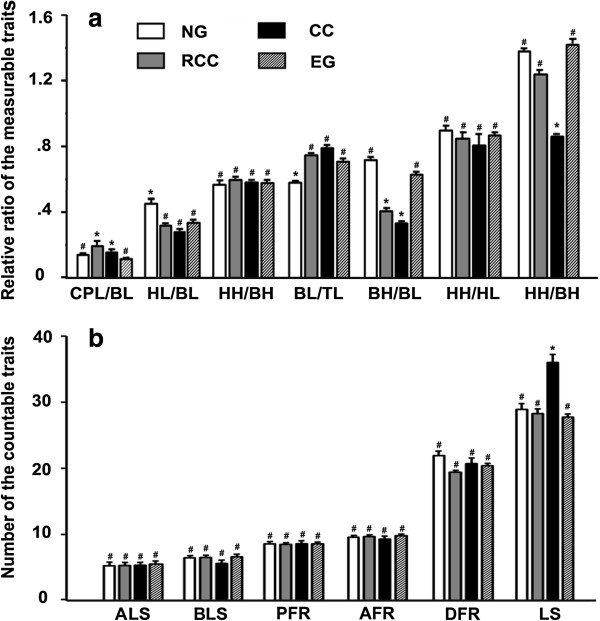
Measurable and countable traits of EG, NG, RCC, and CC. (a) Ratios of the measurable traits. (b) Counts of countable traits. For each trait, mean values that are labeled with different symbols (# or *) are significantly different (P < 0.05). TL, total length; BL, body length; BH, body height; HL, head length; HH, head height; CPL, caudal peduncle length; CPH, caudal peduncle height; LS, lateral line scales; ALS, scale rows above the lateral line; BLS, scale rows below the lateral line; DFR, dorsal fin rays; PFR, pelvic fin rays; AFR, anal fin rays.